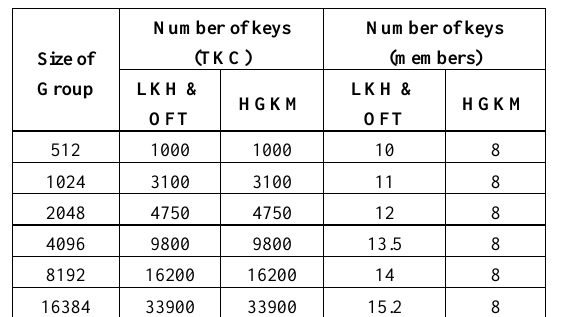
Table 2. The key storage cost for the TKC and members in HGKM, LKH, and OFT